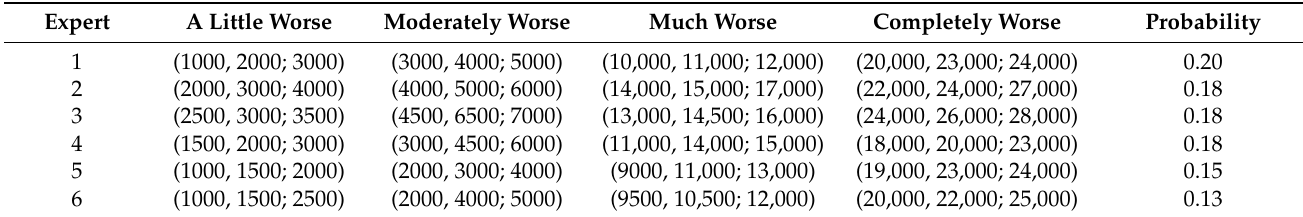
Table 6. Cost overrun for each level of worsening.